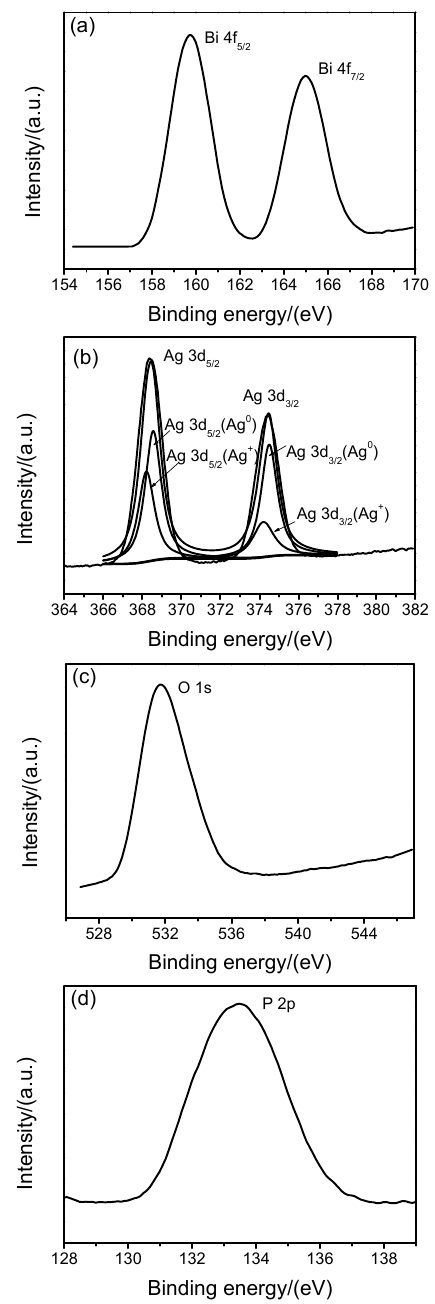
Figure 2. X ‐ ray photoelectron spectroscopy (XPS) spectra of Bi 4f, Ag 3d, O 1s, and P 2p of the 71 wt% Ag 3 PO 4 /Ag/Bi 2 O 2 CO 3 composite. ( a ) XPS of Bi ( b ) XPS of Ag ( c ) XPS of O ( d ) XPS of P.